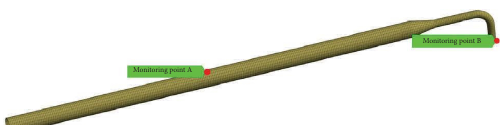
Figure 14: Diagram of the location of the monitoring point.